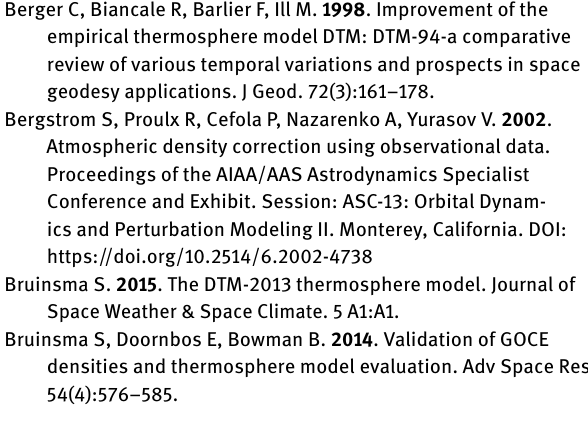
latitude, height, solar radiation proxies, and geomagnetic indices of the measured space taken as the input